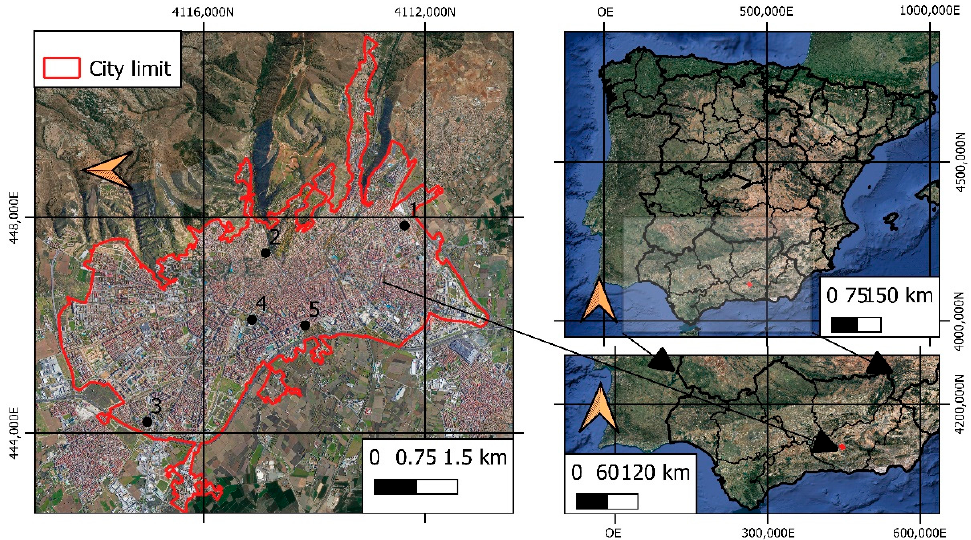
Figure 1. Study area: Granada, Andalusia, Spain.